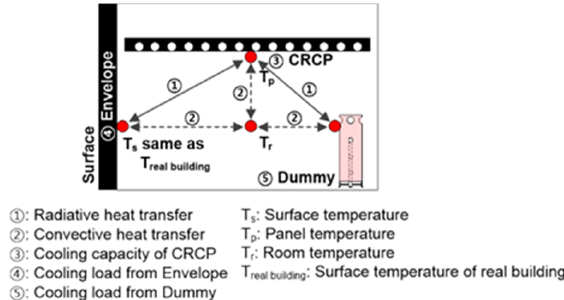
Figure 2. Cooling capacity evaluation regarding boundary condition.